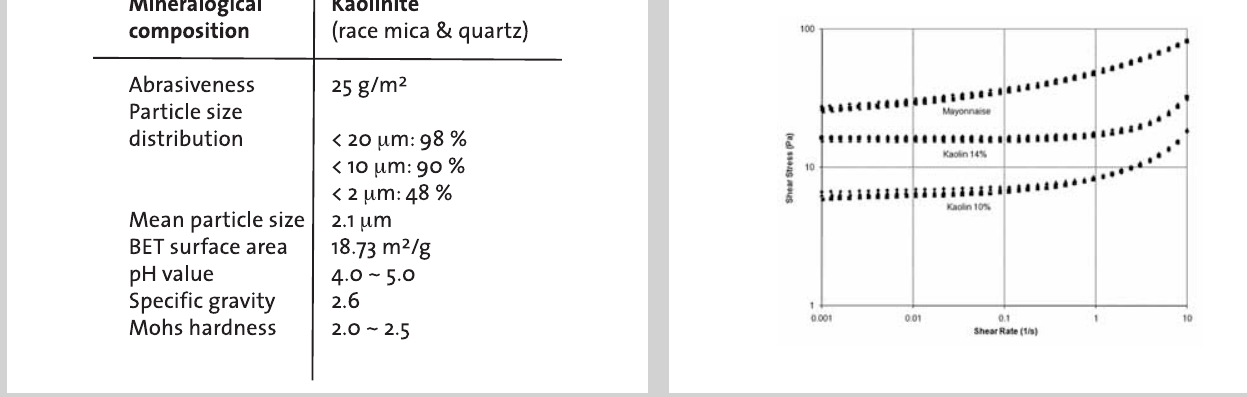
Table 1 (left): Kaolin characteristics. Figure 1 (right): The flow curve of Kaolin-10, Kaolin-14 and mayonnaise sample obtained by parallel- plate geometry with differ- ent gaps ( Ì : 0.8 mm, · : 1 mm, Û : 1.2